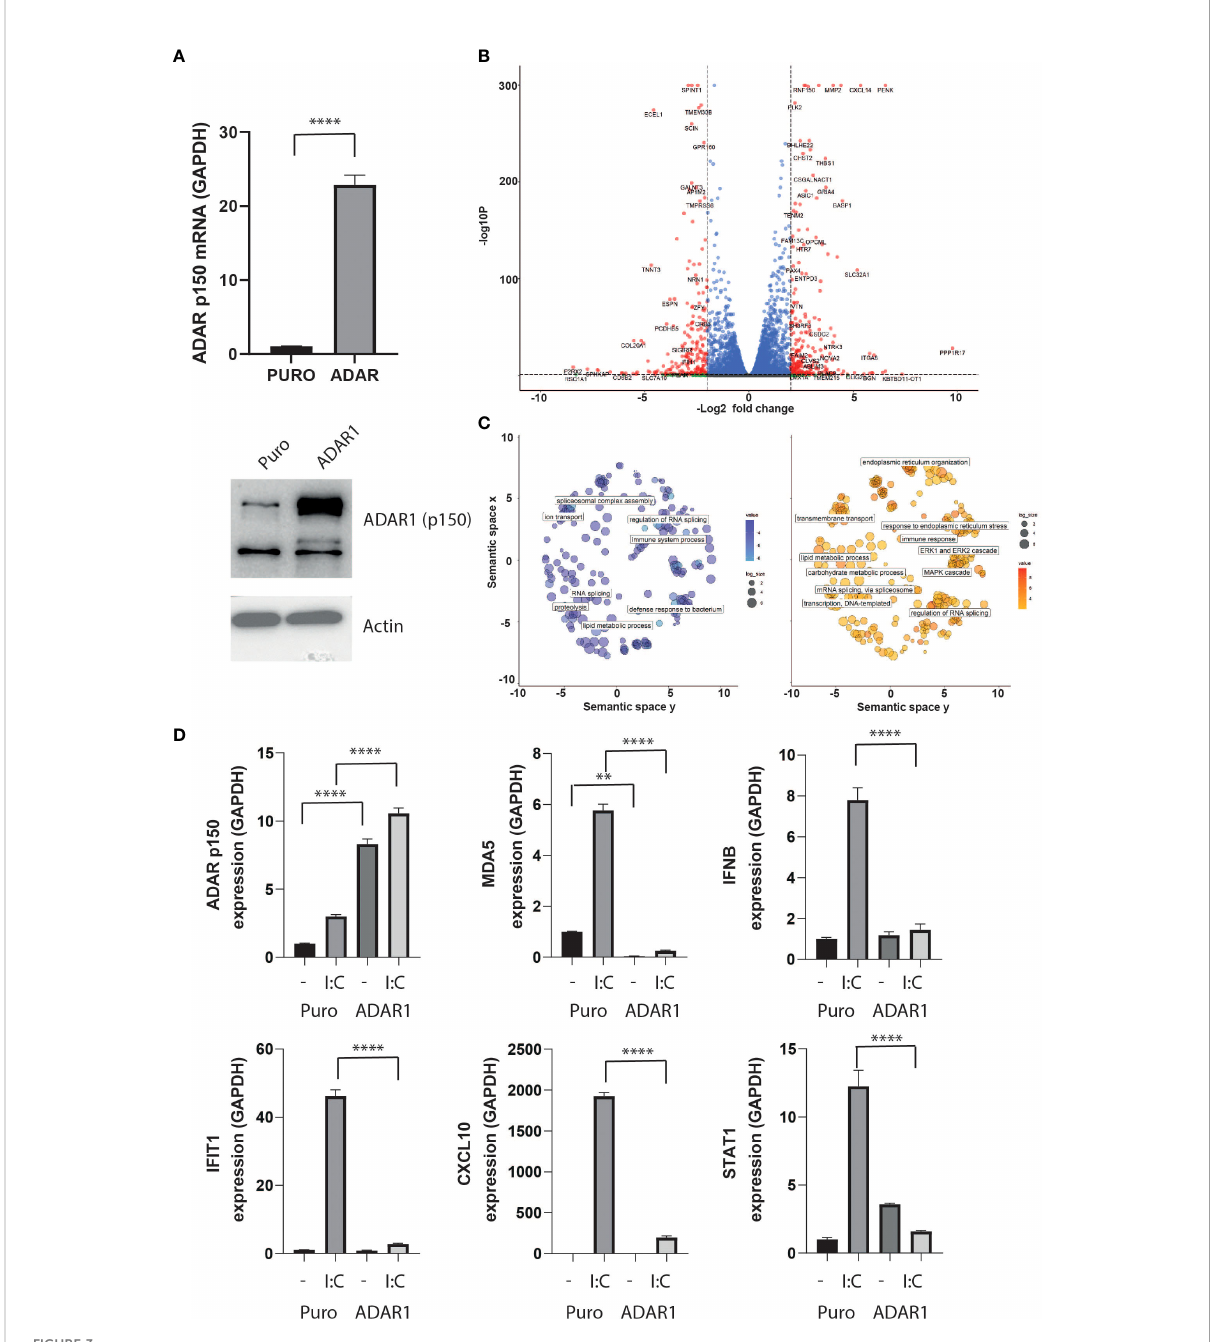
FIGURE 3 ADAR1 overexpression inhibits the type I IFN response. (A) ADAR1 p150 expression in EndoC- b H1 and EndoC- b H1 (ADAR1) cells determined by qPCR (upper panel) and western blot analysis using Anti-ADAR1 #ab168809, Abcam (lower panel). (B) Volcano plot on differential expressing genes after ADAR1 overexpression. Dashed lines show log 2 FC ≤ -2 or log 2 FC ≥ 2 and adj. P value < 0.05. Plot was generated using Enhanced Volcano (C) Pathway analysis on downregulated (left, log 2 FC ≤ -2, adj. P value < 0.05) and upregulated (right, log 2 FC ≥ 2, adj. P value < 0.05) genes. Plots were generated using Revigo. (D) Gene expression of ADAR1 p150, MDA5, IFN b , IFITH1, CXCL10 and STAT1 after ADAR1 overexpression in the presence or absence of polyI:C. N=3 independent experiments. Data are expressed as means of independent experiments ± SEM. Differences between groups were evaluated using one-way ANOVA or linear mixed model in case of missing values, followed by Bonferroni post-hoc test. ** P <0.01 and **** P